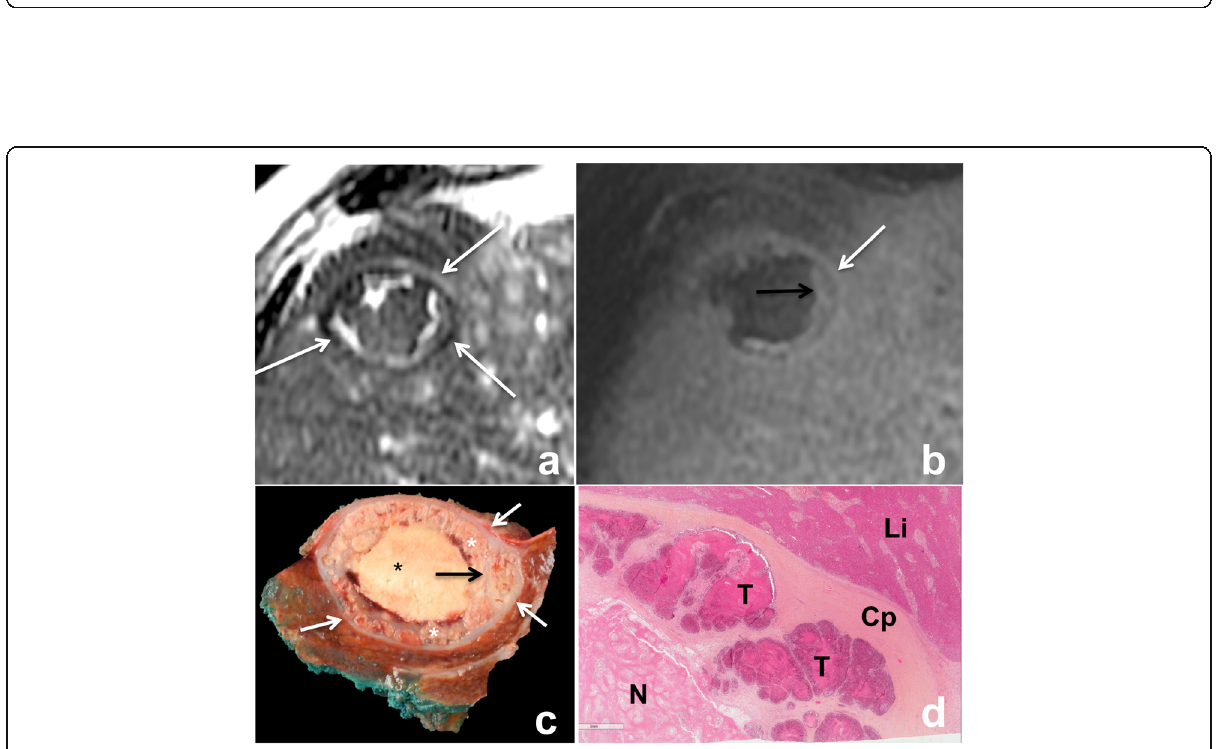
Fig. 2 Capsulated growth pattern in a 50-year-old male patient with metastatic rectal cancer. MR axial fast spin echo T2-weighted image ( a ) shows a 52 mm lesion in segment VIII of the liver surrounded by a hypointense rim (white arrows). On contrast-enhanced fat suppressed gradient recall echo T1-weighted images at delayed 3-minute phase ( b ), the lesion shows a target appearance with a necrotic non-enhanced central area surrounded by the enhancing capsule (white arrow). Note the enhancing fibrous septa in the viable portion of the peripheral tumor (black arrow). Gross pathology ( c ) confirmed the presence of a fibrous capsule (white arrows), surrounding the lesion. Note the central necrosis (black star), the tumoral glands located at the periphery (white stars) and the small fibrous septa across the periphery of the tumor (black arrow). Histological analysis ( d ) confirmed the presence of a peripheral fibrous capsule (Cp) clearly separating the tumor glands (T) from the liver (Li). Note the central necrosis